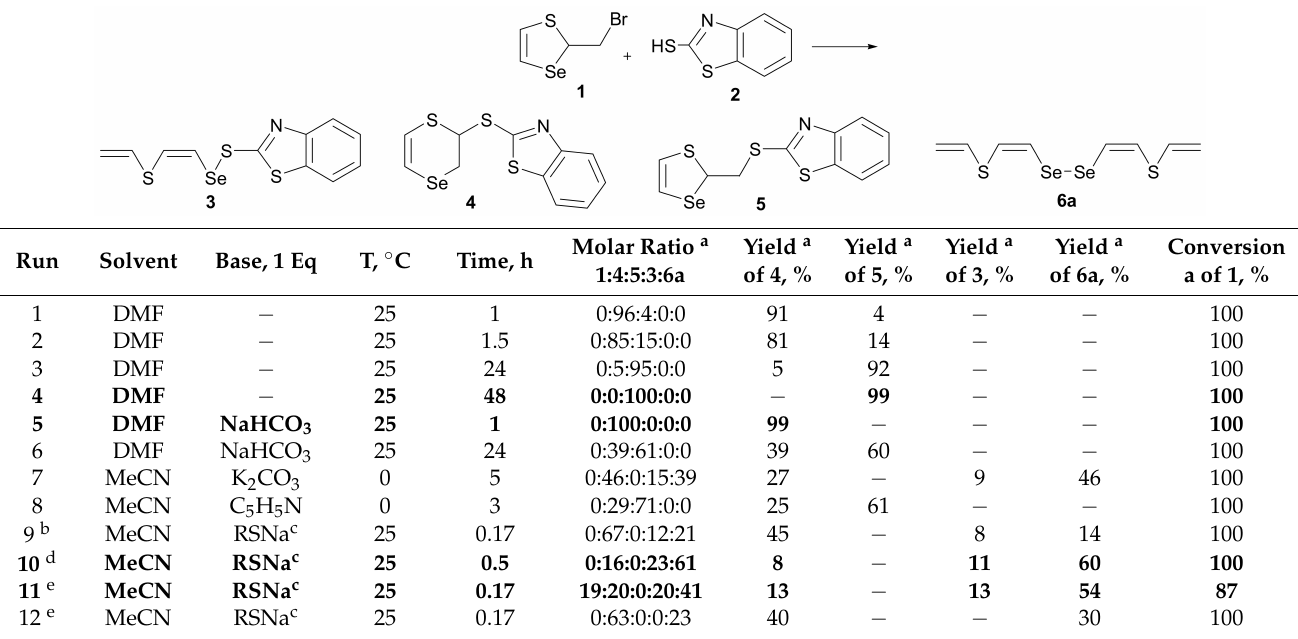
Figure 5. Schematic representation of the disproportionation reaction 3 – 3 → 6a – 6b . It was found that the reaction of thiaselenole 1 with thiol 2 can be carried out without a base in such aprotic bipolar solvent as DMF, which is able to bind evolved hydrogen bromide. Six-membered heterocycle 4 as a major product and five-membered heterocycle 5 as a minor product were formed in 1–1.5 h (Table 1, Runs 1, 2). The latter compound became the major product in 24 h (Table 1, Run 3). The six-membered product 4 was completely rearranged into five-membered heterocycle 5 in a 99% yield (Table 1, Run 4). Thus, new regioselective conditions for the quantitative preparation of heterocycle 5 were found. Table 1. The influence of conditions on the yields and the ratio of products in the reaction of thiaselenole 1 with thiol 2 (or